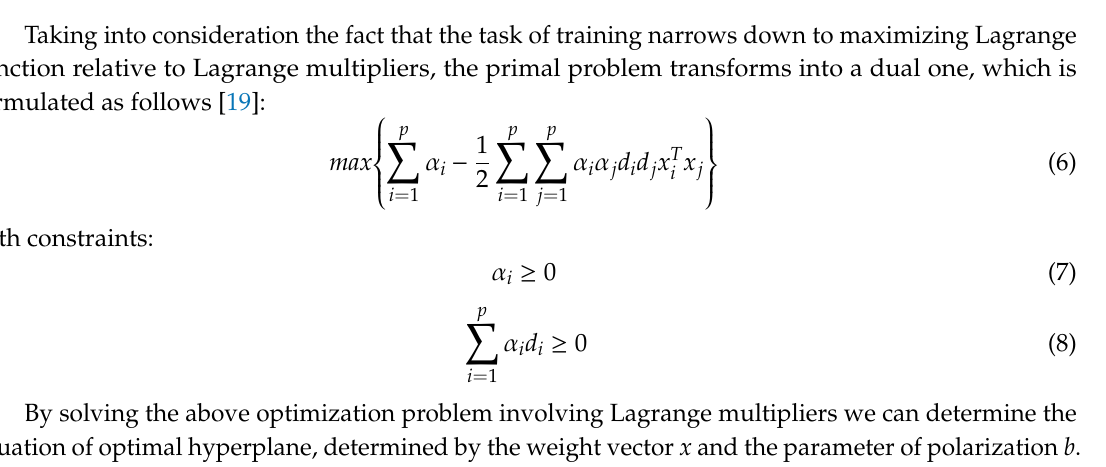
Figure 5. Interpretation of the margin of separation between data classes.